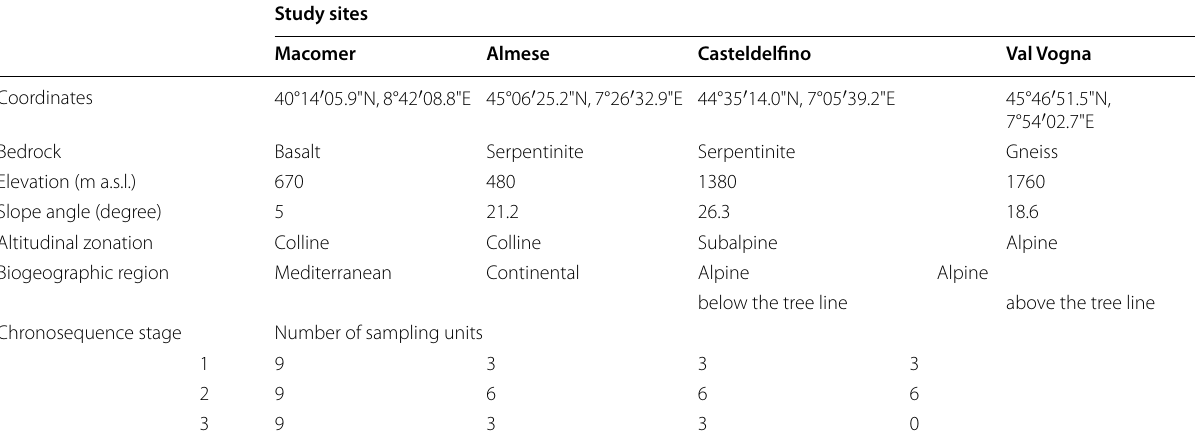
Table 1 Coordinates, bedrock, topographic features, biogeographic region, and number of sampling units per each chronosequence stage of the four study sites located in